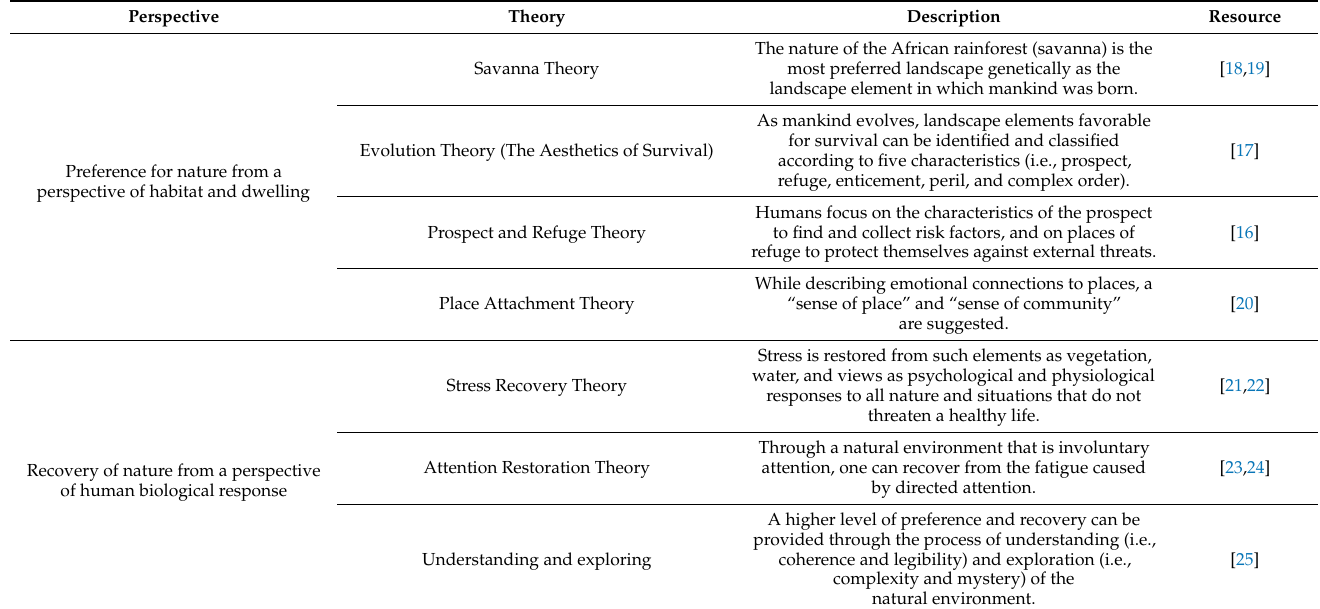
Table 1. Theories regarding the relationship between humans and the natural